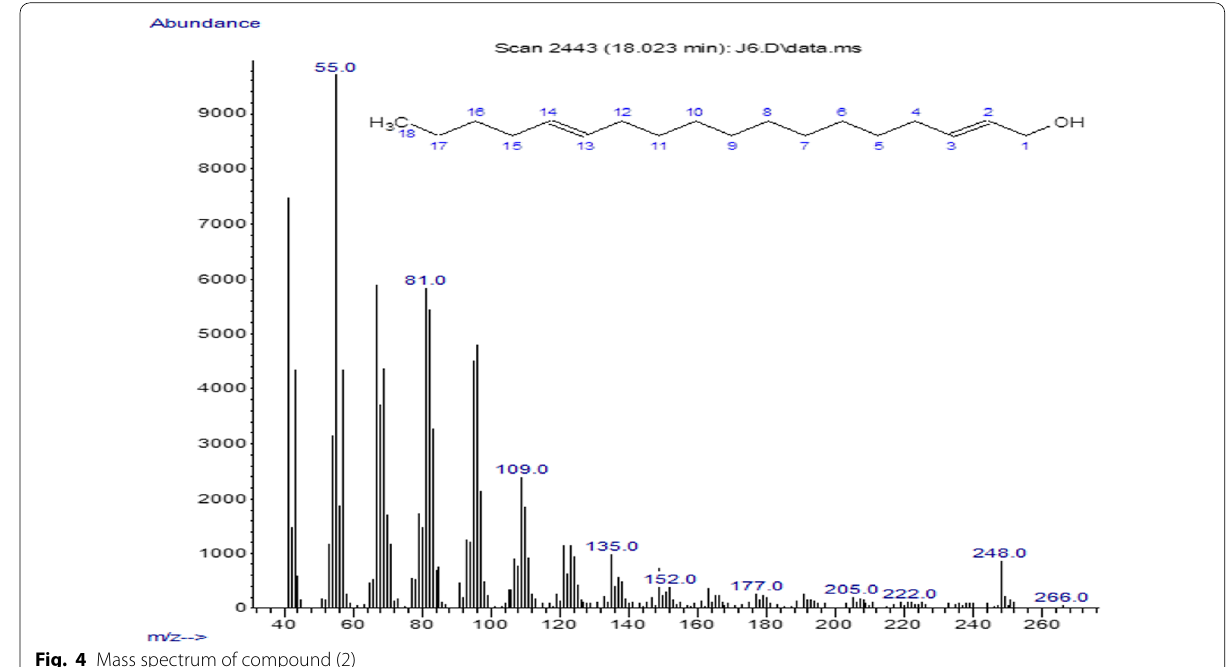
Fig. 4 Mass spectrum of compound (2)